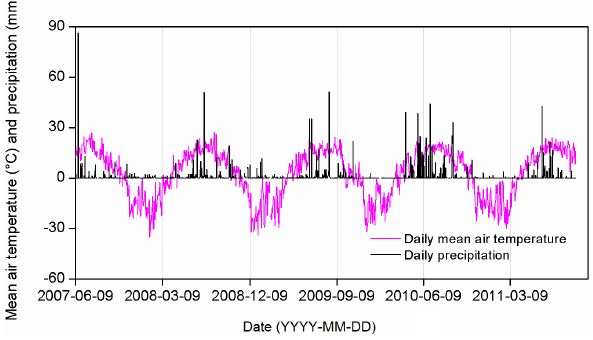
Figure 2. Daily mean air temperature and precipitation during the study